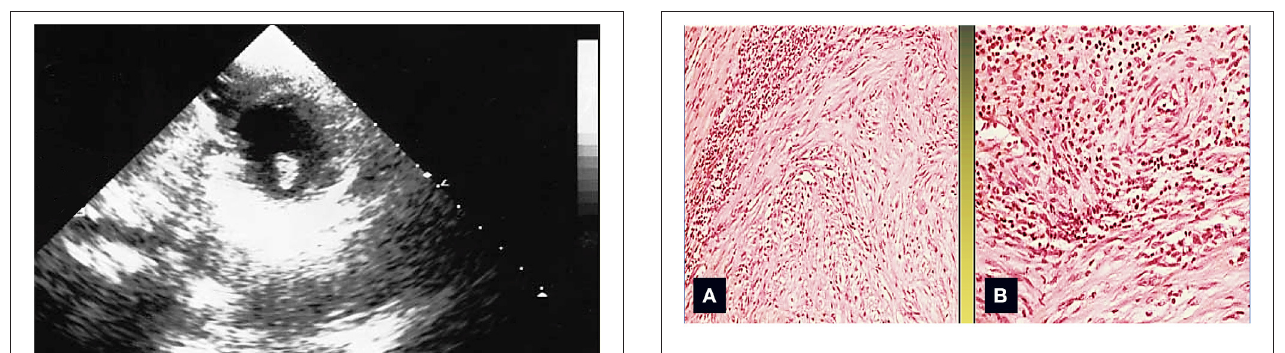
FIGURE 2 | The area between the tumor and the normal myocardium is characterized by a mixed inflammatory infiltrate composed of polymorphonuclear leukocytes, lymphocytes, monocytes, and plasma cells (Col. Hem-Eos, original magnification × 40: A,B ).